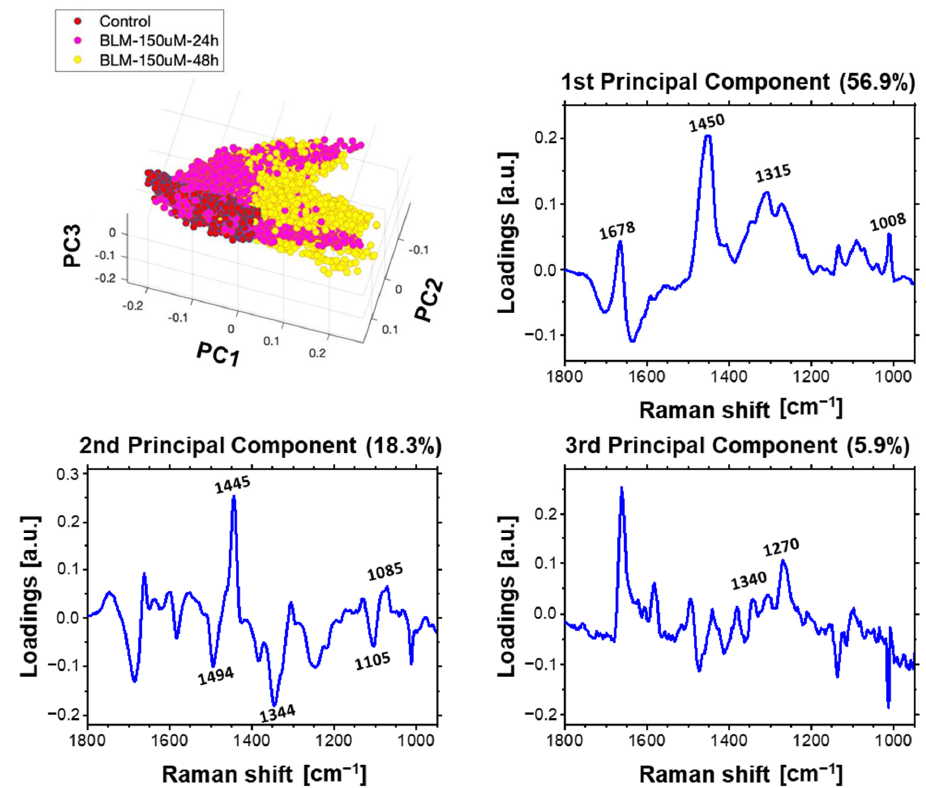
Figure 9. Time-dependent effect of BLM incubation. Results of PCA for Raman spectra acquired from nuclei of control cells and cells treated with. 150 µM of BLM for 24 and 48 h. Loading plots of three first principal components are presented.